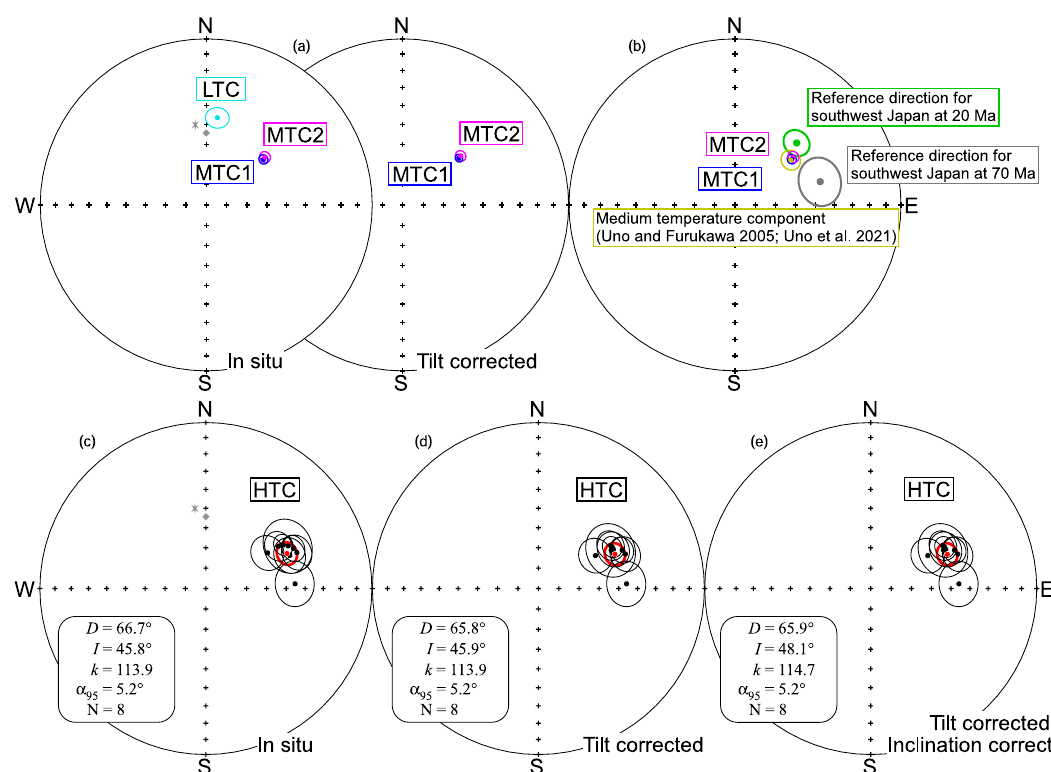
Fig. 5 a Equal-area projections of mean directions (with an associated 95% confidence limit) of LTC, MTC1, and MTC2, b and those depicted along with the directions of the previously observed medium-temperature component of Cretaceous red beds from southwest Japan (Uno and Furukawa 2005; Uno et al. 2021) and the reference direction for southwest Japan at 70 and 20 Ma (Uno et al. 2021). The asterisk and diamond represent the present Earth’s field direction and axial dipole field direction, respectively. c – e Site-mean directions of HTC. The red symbols represent the mean direction and associated 95% confidence